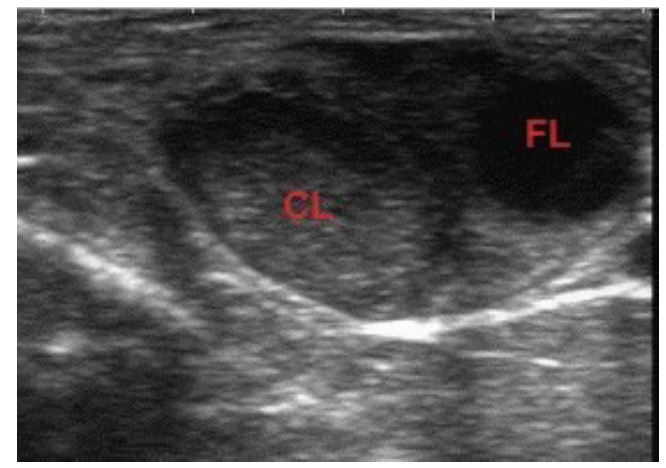
Figure 2. Ultrasound image of the cyclic heifer ovary with the presence of a corpus luteum (CL) and an antral follicle